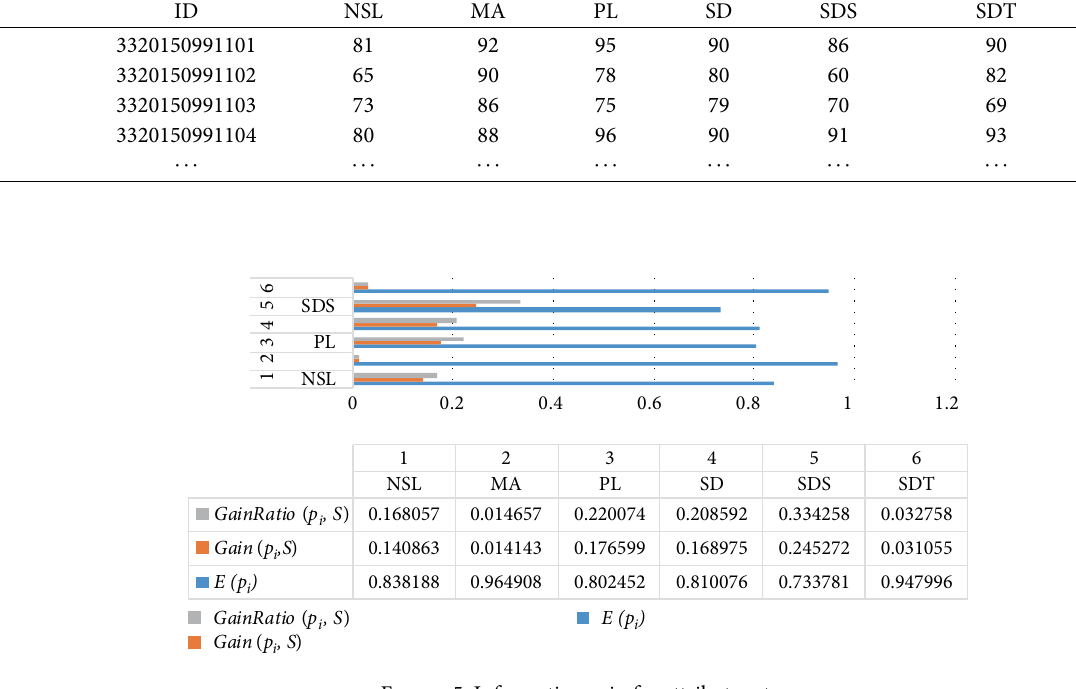
Figure 5: Information gain for attribute